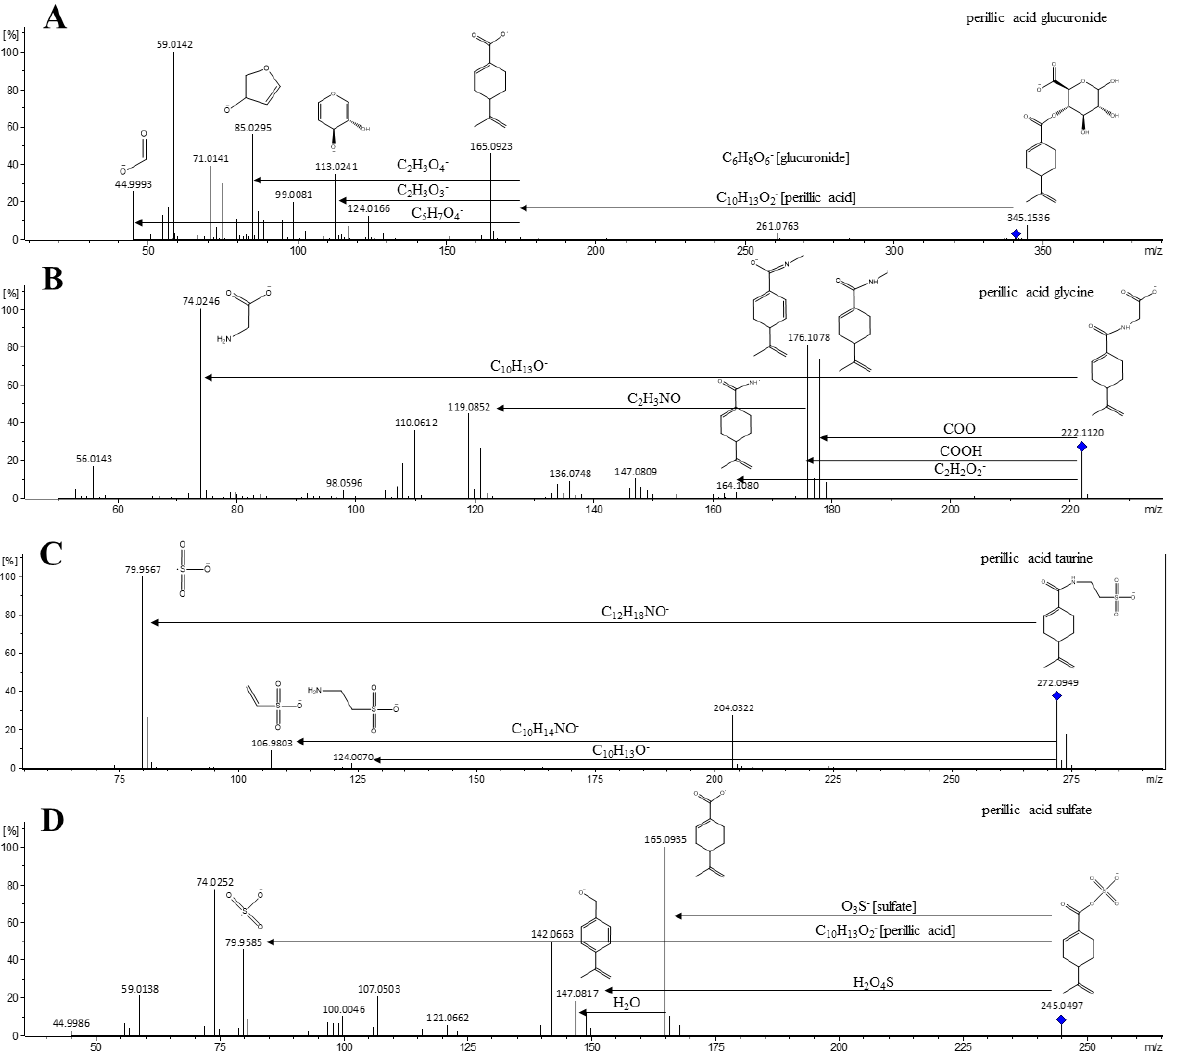
Figure 2. Fragmentation map of different phase II metabolites from perillic acid. ( A ) perillic acid glucuronide; ( B ) perillic acid glycine; ( C ) perillic acid taurine; and ( D ) perillic acid sulfate.